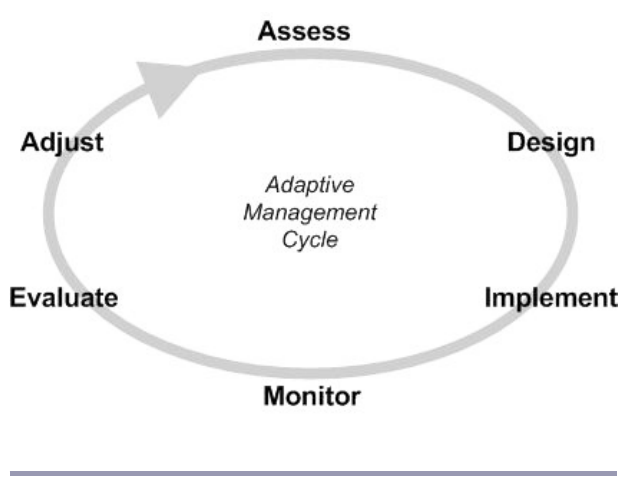
Fig. 2. The adaptive management